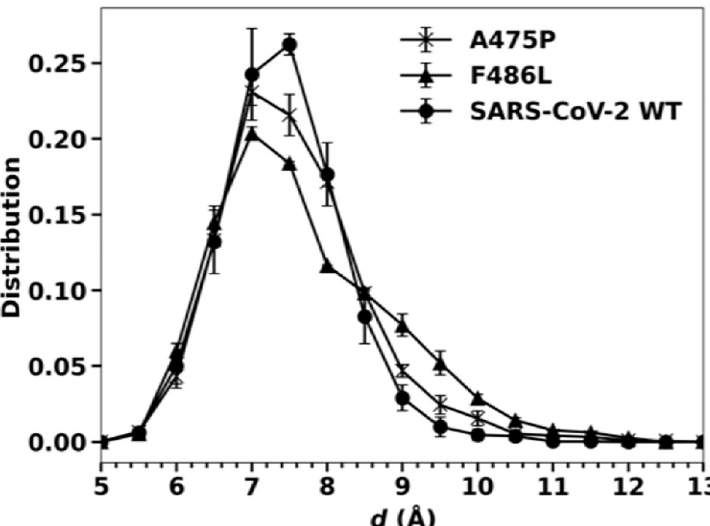
Fig 5. Distribution of the distance d between the C α s of L486 of the F486L mutant and L79 of ACE2 and compared to d between F486 of the A475P mutant and L79 of ACE2.